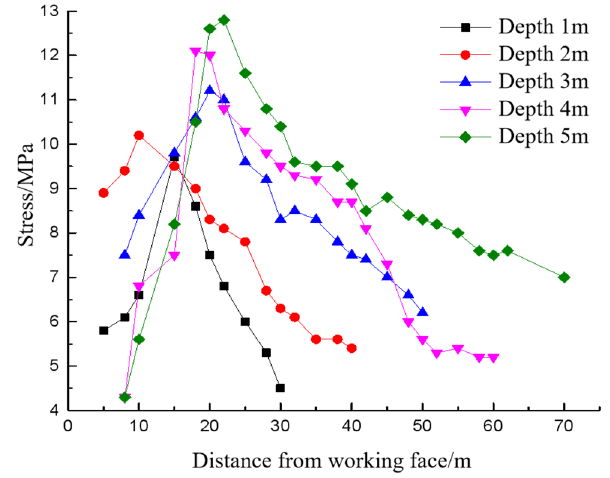
Figure 18. Stress monitoring results.